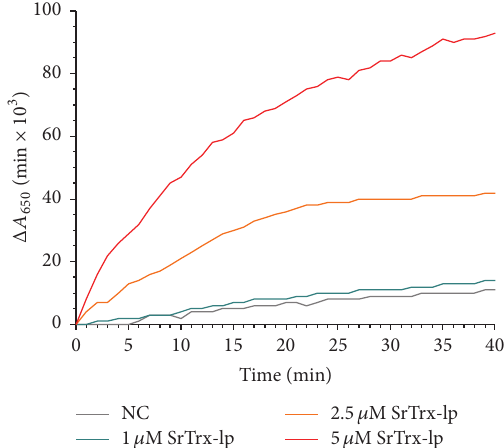
Figure 3: SrTrx-lp catalyzed reduction of insulin by DTT. Here, the rate of precipitation was plotted against time. While after 40 min the reduction of the SrTrx-lp was near the equilibrium, only a minorreductionofinsulinwasdetectedinthenegativecontrol(NC) without the SrTrx-lp and the lowest concentration used of SrTrx-lp (1 𝜇